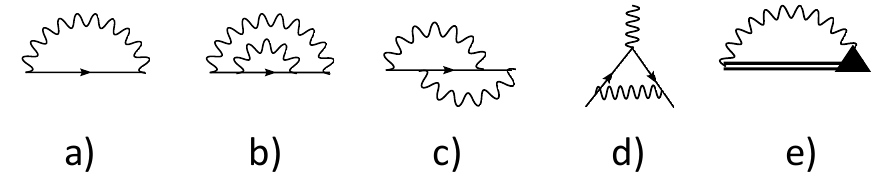
Figure 6: Self-energy part diagrams a) first order perturbation theory; b) and c) second order of perturbation theory; d) first order vertex correction; e) bold self- energy part. Single straight line denoted bare Green’s function, double solid line denotes bold (dressed) Green’s function. Wavy line stands for the Gaussian classical random field correlator. Bold triangle denotes the full vertex Γ